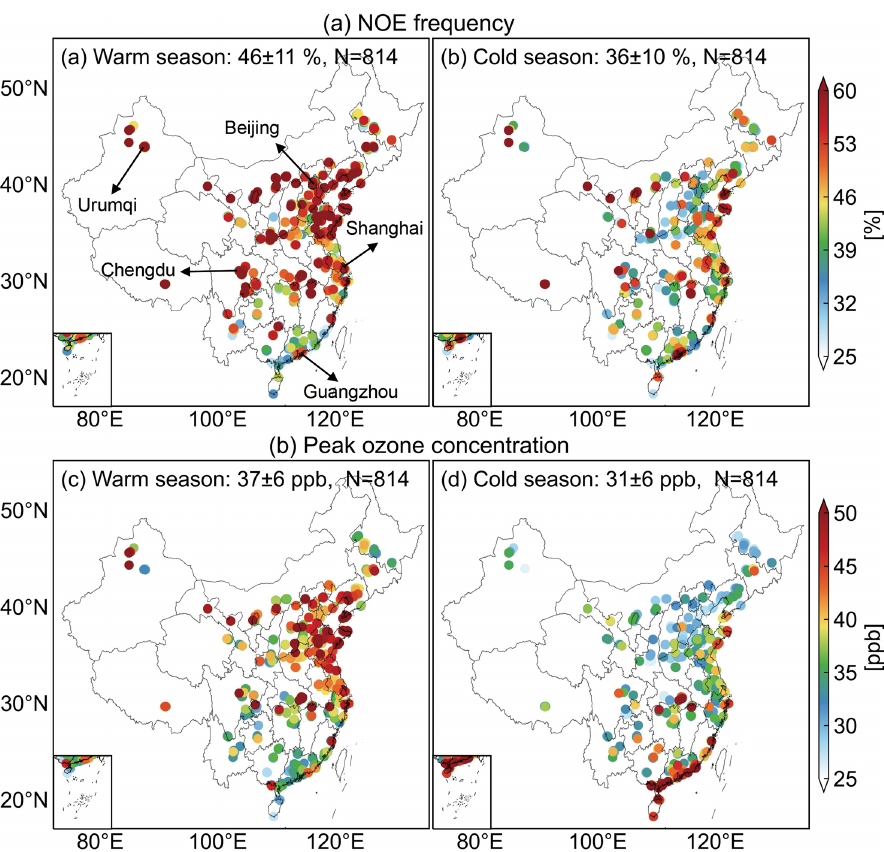
Figure 2. Comparison of the NOE event frequency and nocturnal peak ozone concentrations between the ( a , c ) warm season (April– September) and ( b , d ) cold season (October–March) in China. The regional mean values and standard deviations among the N sites are shown inset at the top of each figure (mean ± standard